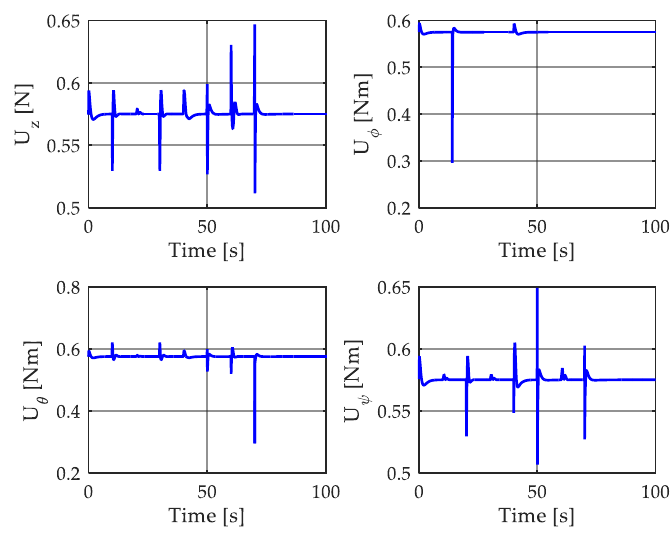
Figure 10. Control inputs.